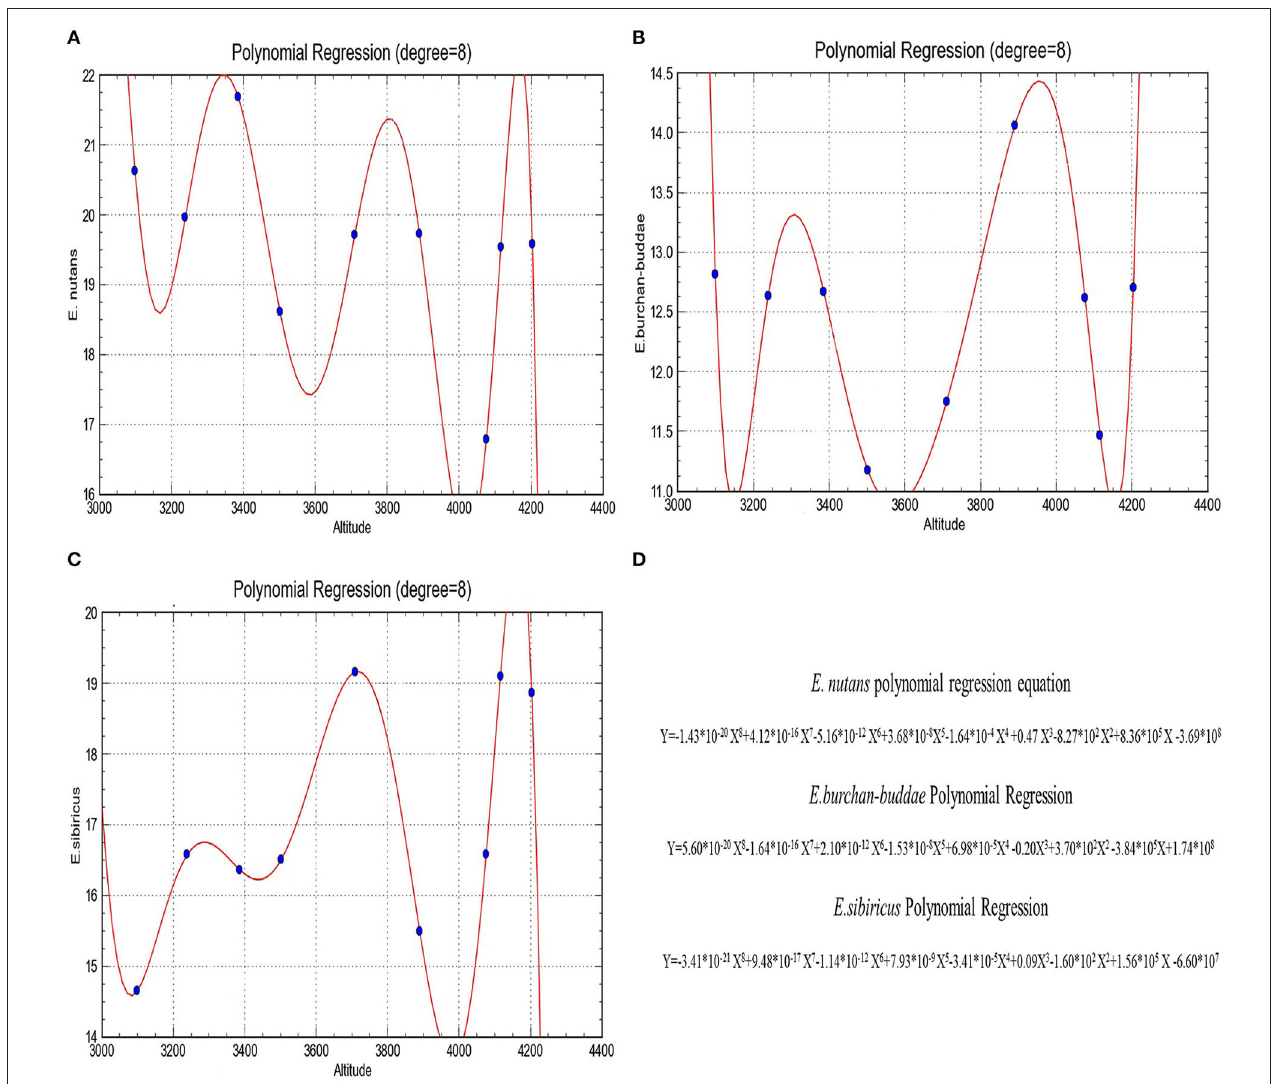
FIGURE 2 | Curve regression analyses of three Elymus species: (A) E. nutans , (B) E. burchan-buddae , and (C) E. sibiricus ; (D) , polynomial regression analyses of three Elymus species.